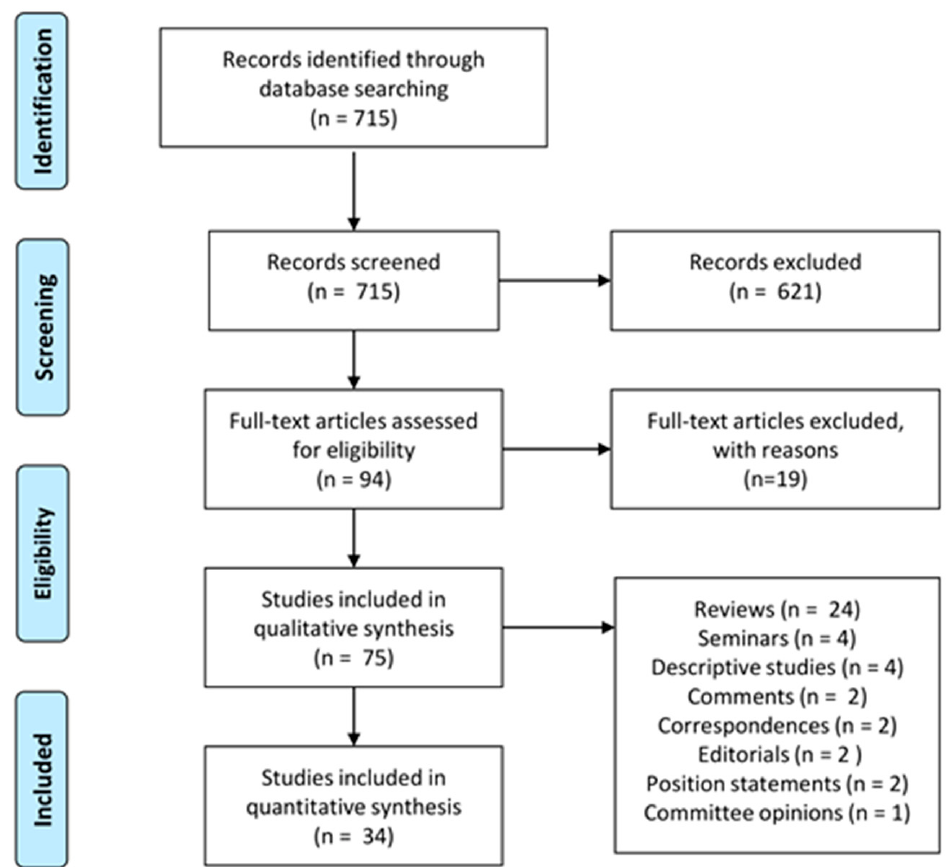
Figure 3. PRISMA systematic review flow chart. The chart illustrates the review process performed highlighting the number of papers identified, screened, elected and included in qualitative and quantitative synthesis.